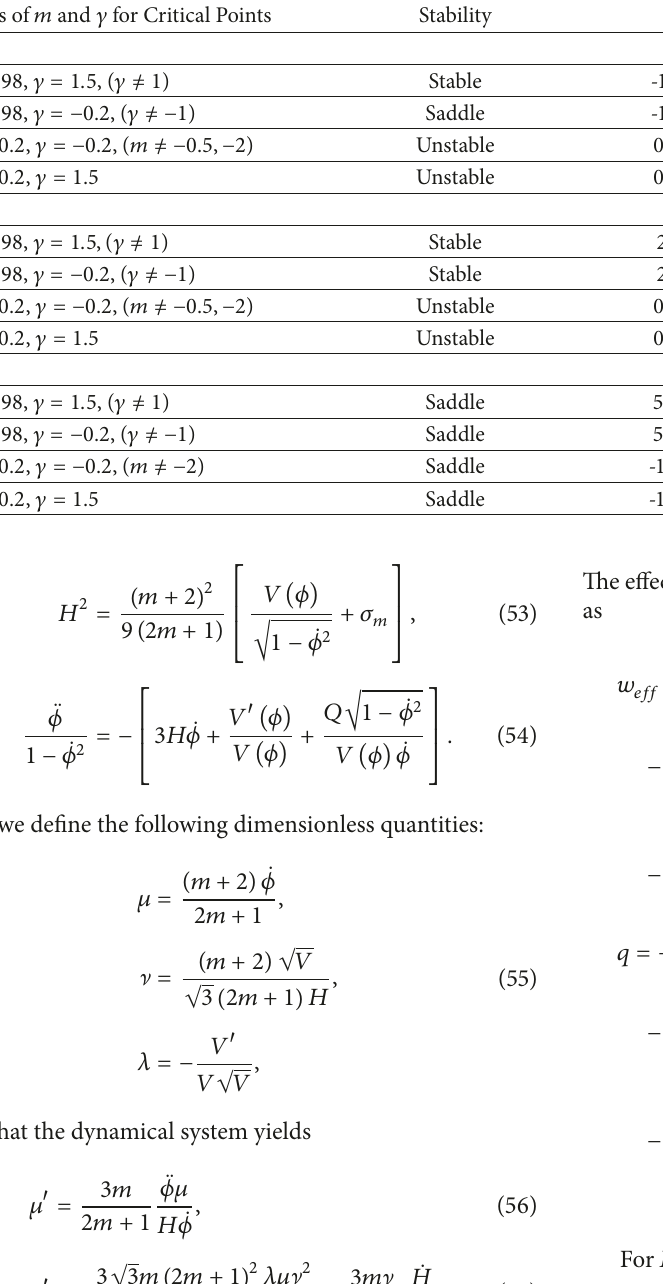
Table 3: Phase Space Analysis for 𝑄 = 𝛾( ̇𝜎 𝑚 + ̇𝜎 𝜙 ) .